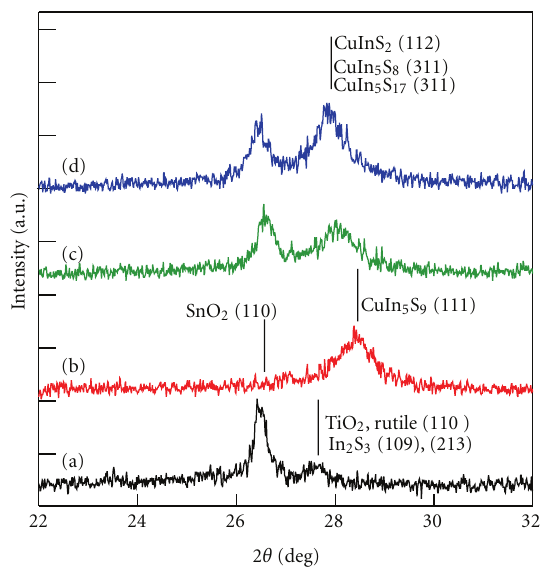
Figure 3: XRD patterns of (cid:2) glass / FTO / TiO 2 / In 2 S 3 (cid:3) (a), (cid:2) glass / Cu-In-S (cid:3) (b), (cid:2) glass / FTO / TiO 2 / Cu-In-S (cid:3) (c), and (cid:2) glass / FTO / TiO 2 / In 2 S 3 / Cu-In-S (cid:3) (d). Numbers in round brackets show the crystal plane of materials in reference to JCPDS card